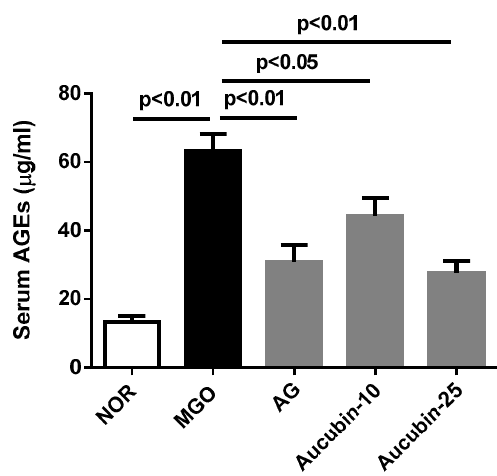
Figure 4. Circulating AGEs formation in the blood of exogenous MGO-injected rats. NOR, normal control rats; MGO, exogenous MGO-injected rats; AG, MGO treated with aminoguanidine (50 mg/kg); Aucubin-10, MGO treated with aucubin (10 mg/kg); Aucubin-25, MGO treated with aucubin (25 mg/kg). All data are expressed the mean ± SE, n = 6.